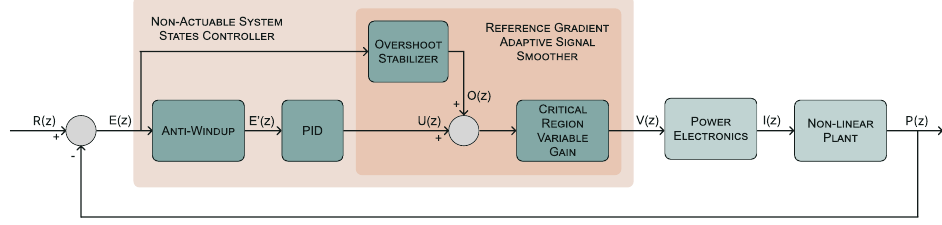
Figure 7. NASS controller scheme. R ( z ) is the reference, P ( z ) is the measured position, E ( z ) is the error, E (cid:48) ( z ) is the weighted error, U ( z ) is the PID control signal, O ( z ) is the offset, V ( z ) is the final control signal, and I ( z ) is the intensity given to the